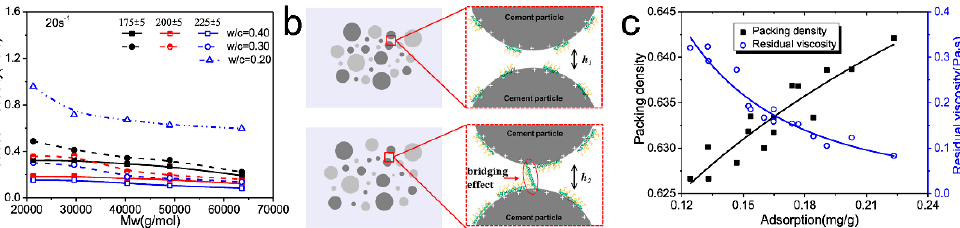
Figure 6. Residual viscosity of cement paste at 20 s − 1 ( a ); “bridging effect” for PCE with low molecular weight (top) and high molecular weight (bottom) ( b ); packing density and residual viscosity of cement paste with all 5 PCE samples as the adsorption amount increases ( c ). Authorized reprint from Ref. [62].